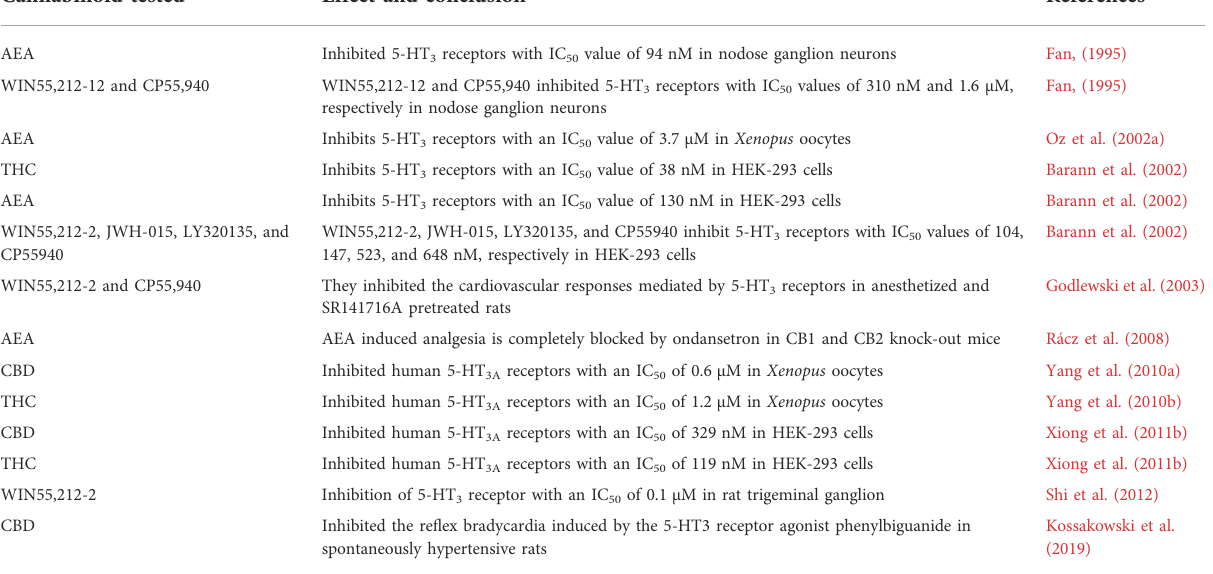
TABLE 2 Effects of cannabinoids on 5-HT 3